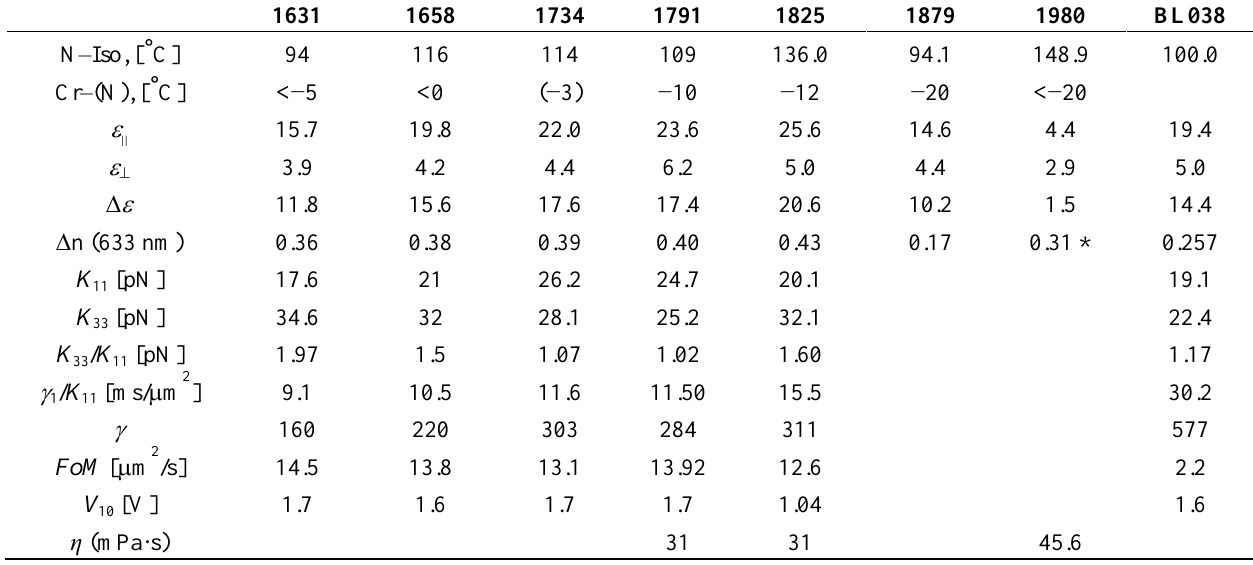
Table 17. Physical properties of high birefringent mixtures prepared from isothiocyanates (1631, 1658, 1734, 1791, 1825), fluorides (1879, 1980) and cyanides (BL038).